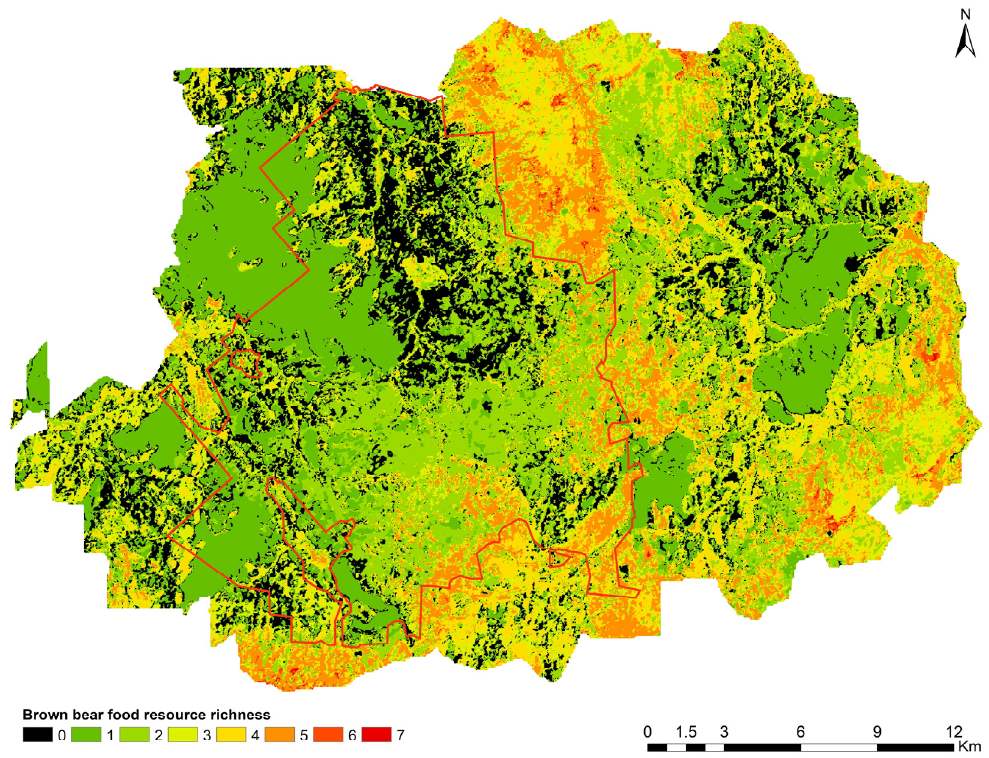
Figure 6. Prevalence (predicted presence area in %, corrected by size of territory type) for the main brown bear food resources in the Central Forest State Nature Reserve core and its buffer zone (West-European Russia) in 2008–2020. Black dotted line indicates equal area (50%) for both area types. Labels indicate prevalence in% for each food resource by area type.